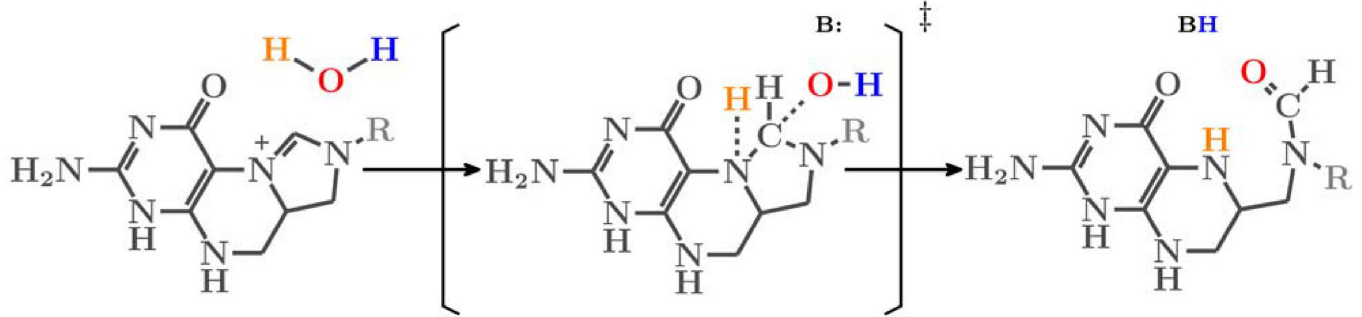
PLOS Computational Biology | https://doi.org/10.1371/journal.pcbi.1010140 May 25,